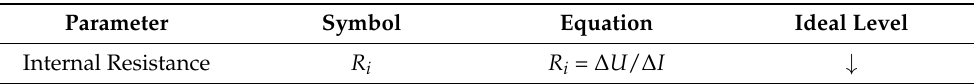
Table 4. Parameter derived from the current pulse.